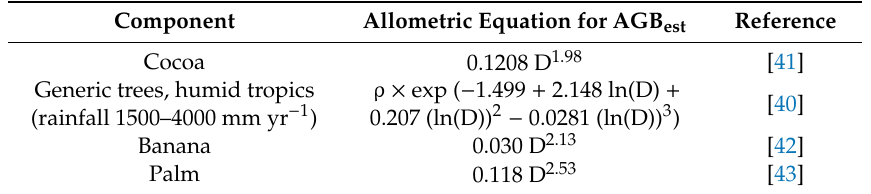
Table 2. Allometric equations used for aboveground biomass (AGB est ) based on stem diameter